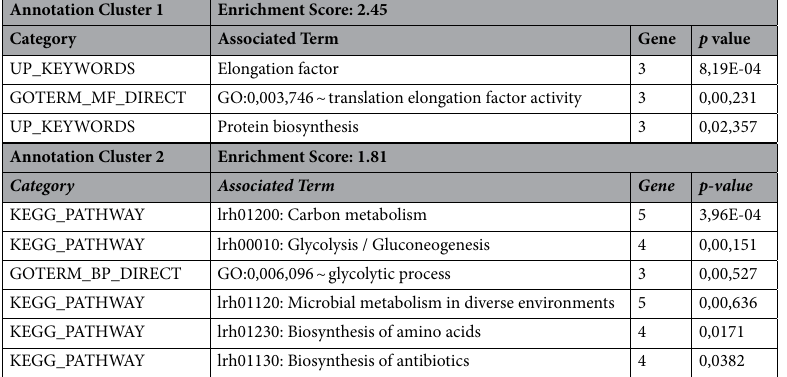
Annotation cluster